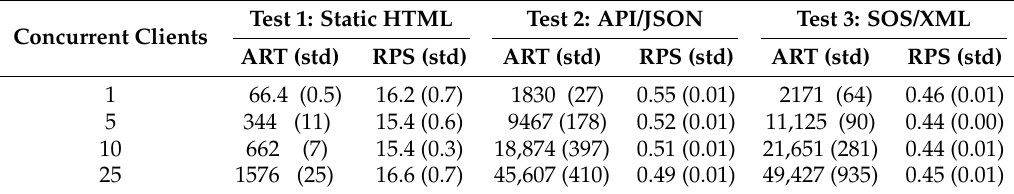
Table 3. Experimental results for the three tests and for different numbers of concurrent clients. Average response time (ART) across a hundred requests for each document are reported in milliseconds. System throughput is expressed in requests per second